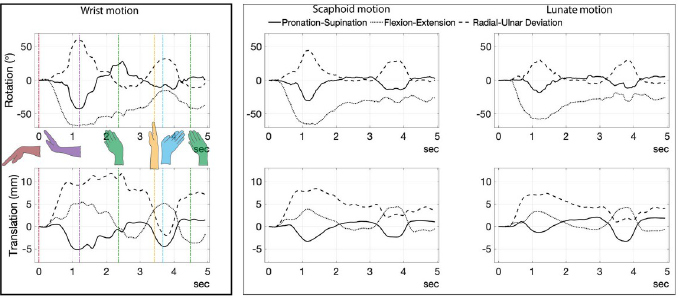
Fig 11. Filtered motion of wrist, scaphoid, and lunate for flexion (first frame) acquired from tri-planar video- radiography [41]. Times 0; 1.11; 2.355; 3.42; 3.67 and 4.485 seconds correspond to flexion (red), extension (purple), radial deviation (green), neutral (yellow), ulnar deviation (cyan) and radial deviation again (green),